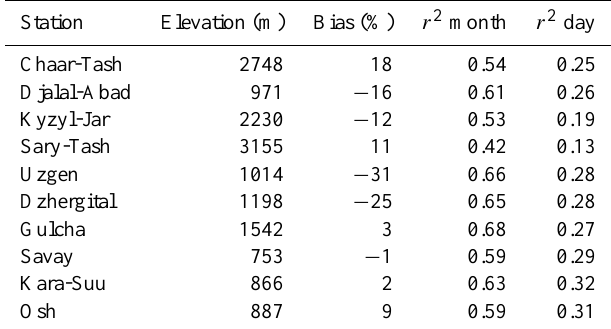
Fig. 3. Bias and mean absolute error calculated from cross valida- tion for the interpolation methods WRFadj-all, WRFadj-ind, MLR- all, MLR-ind and IDW for precipitation stations in or close to the Karadarya